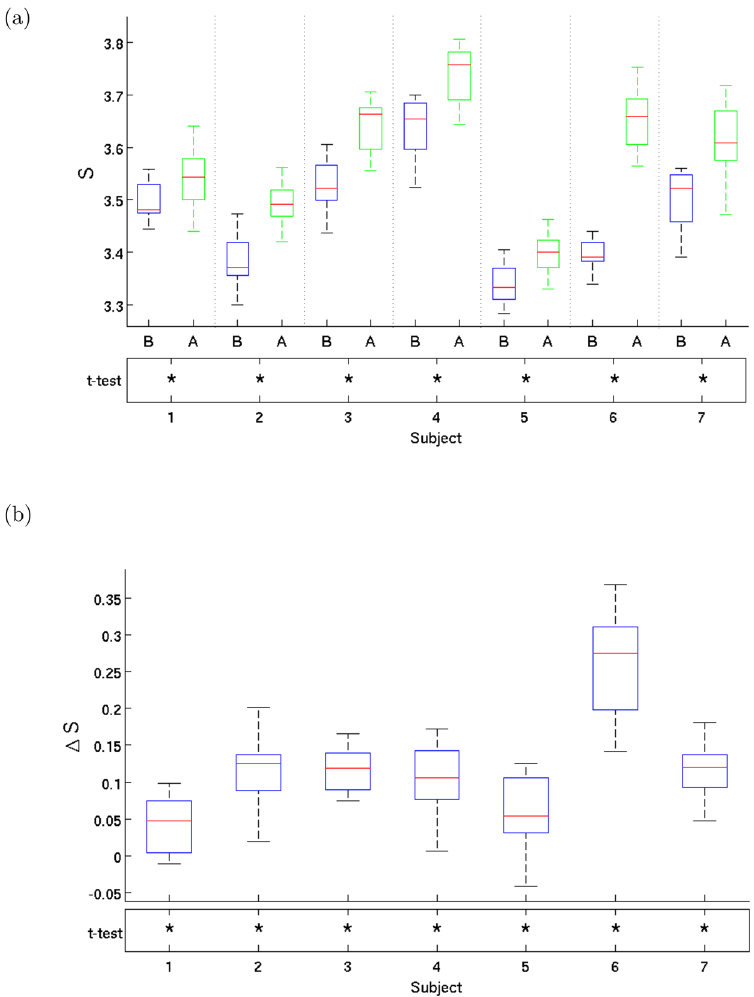
Figure 4. Entropy growth per subject. ( a ) Boxplot of the entropy distribution and before ( B ) and after ( A ) Ayahuasca ingestion and ( b ) boxplot of entropy increase, for all 7 subjects. Note the significant increase in entropy after Ayahuasca ingestion. There are 16 values of entropy per subject, as discussed in the text. The bars show minimum and maximum values and the box shows the 2nd and 3th quartiles, with the median shown dividing the box (in red). The asterisks ( * ) in the bottom rows in both plots indicate p -values p < 0.005 for Student’s paired t -test in ( a ) and t -test for zero mean in ( b ). Subject-by-subject, we thus find strong evidence against the null hypothesis of no entropy